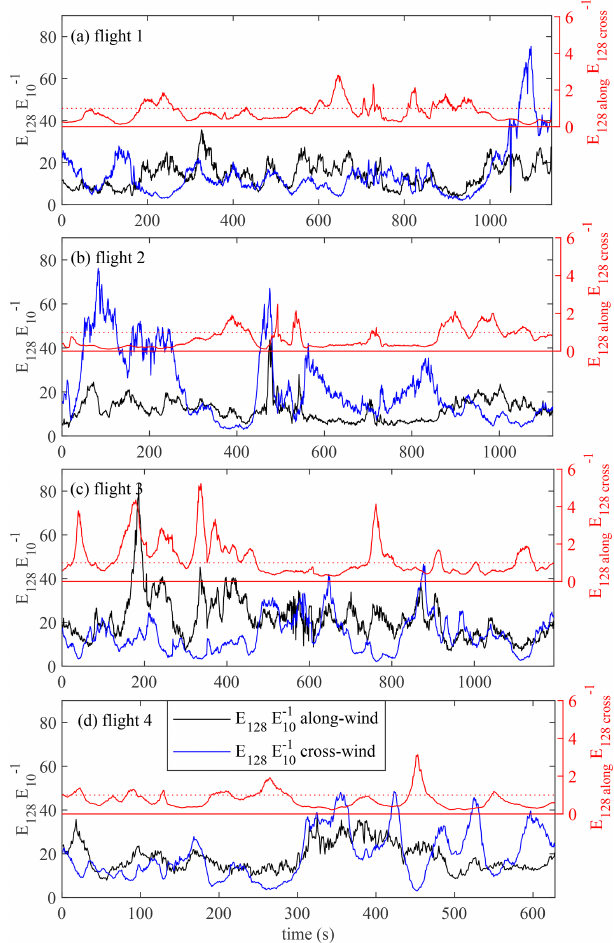
Figure 10. The ratio between the FFT spectral powers at the scales of 128 to 10m for the along- and cross-wind directions (black and blue lines, respectively) and the along- to cross-wind spectral power ratio at the scale of 128m (red